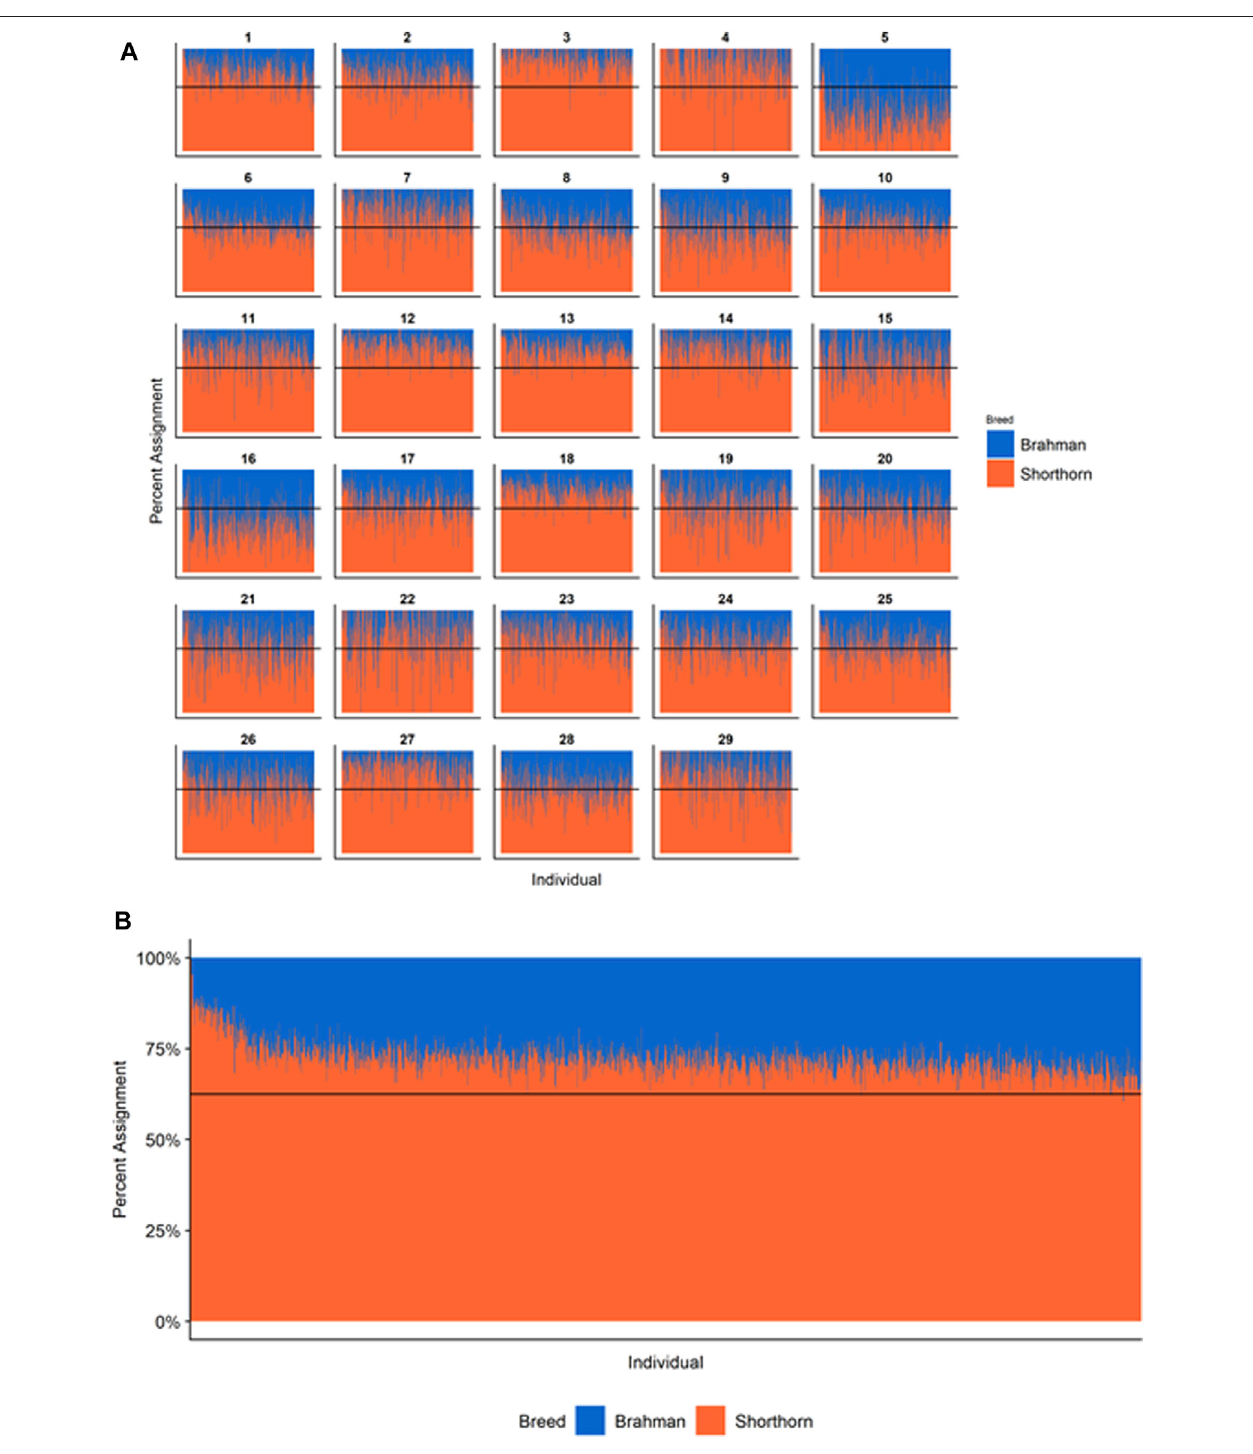
FIGURE 5 | Ancestry estimated by RFMix for each Santa Gertrudis individual plotted with animals sorted by total number of haplotypes. (A) Ancestry assignment for each chromosome, and (B) Genome-wide ancestry. Individuals are represented by vertical bars within each plot with Brahman proportion in blue and Shorthorn proportion in orange. Animals to the left on the X -axes have the fewest number of haplotypes predicted within their genomes. The black line represents the expected proportion of 5/8 Shorthorn.